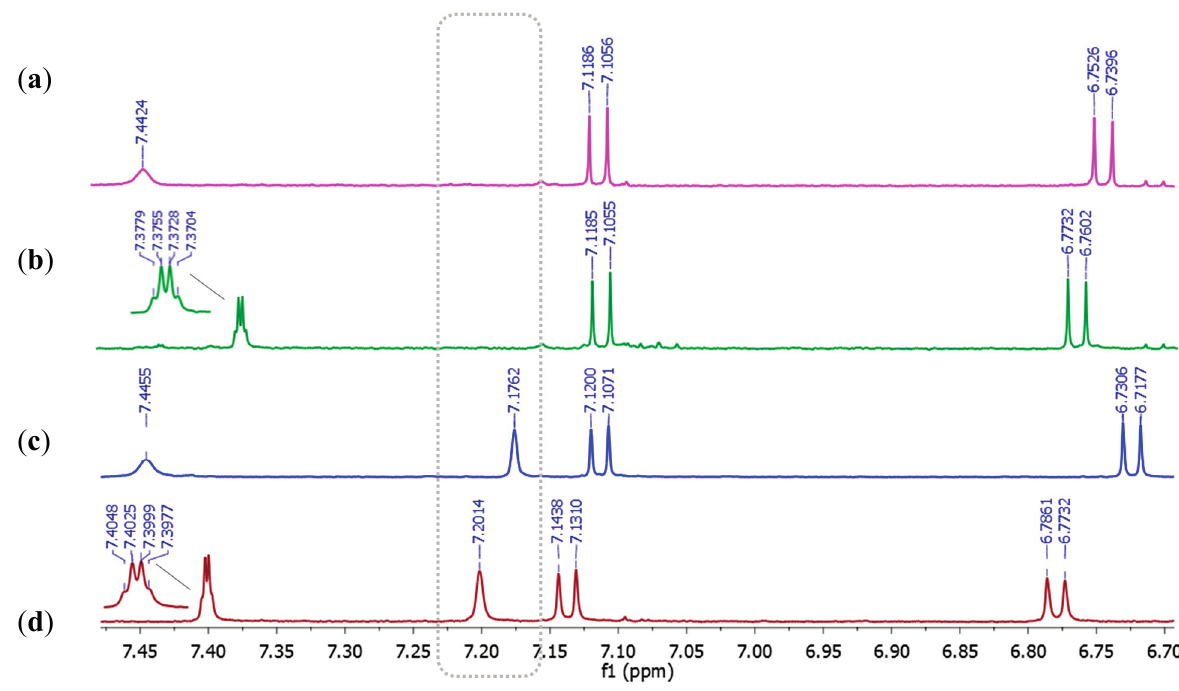
Figure 4. Amplified regions from the 1 H-NMR spectra of (600 MHz, methanol- d 4 ) ( a ) 2,8-dichlororugulovasine B; ( b ) 2,8-dichlororugulovasine A; ( c ) 8-chlororugulovasine B; and ( d ) 8-chlororugulovasine A. Region of vinylic protons is